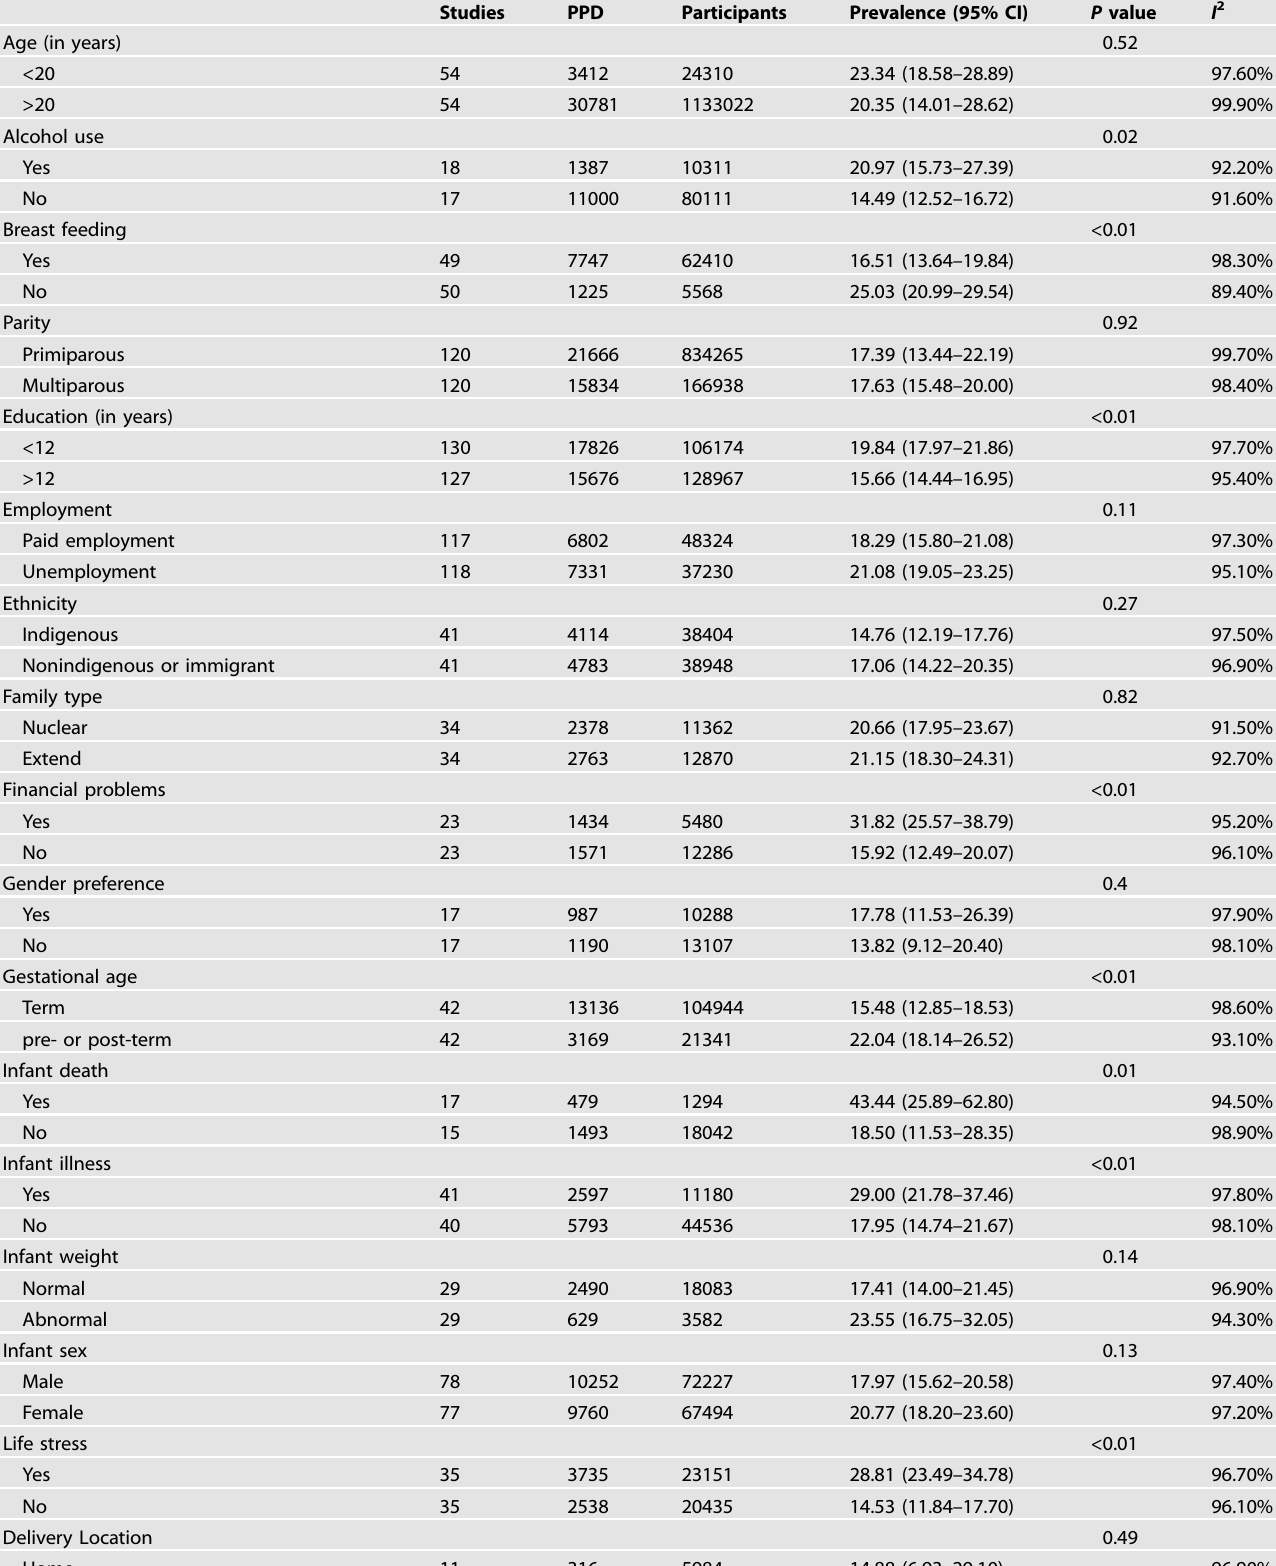
Table 2. Pooled estimates of risk factors for